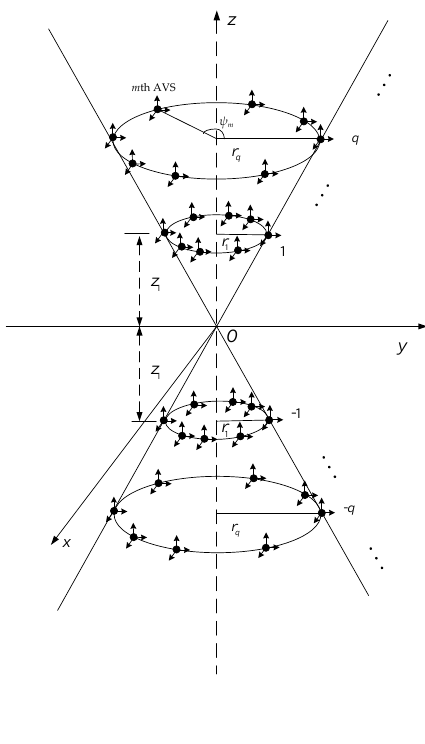
Figure 1. Geometry diagram of the